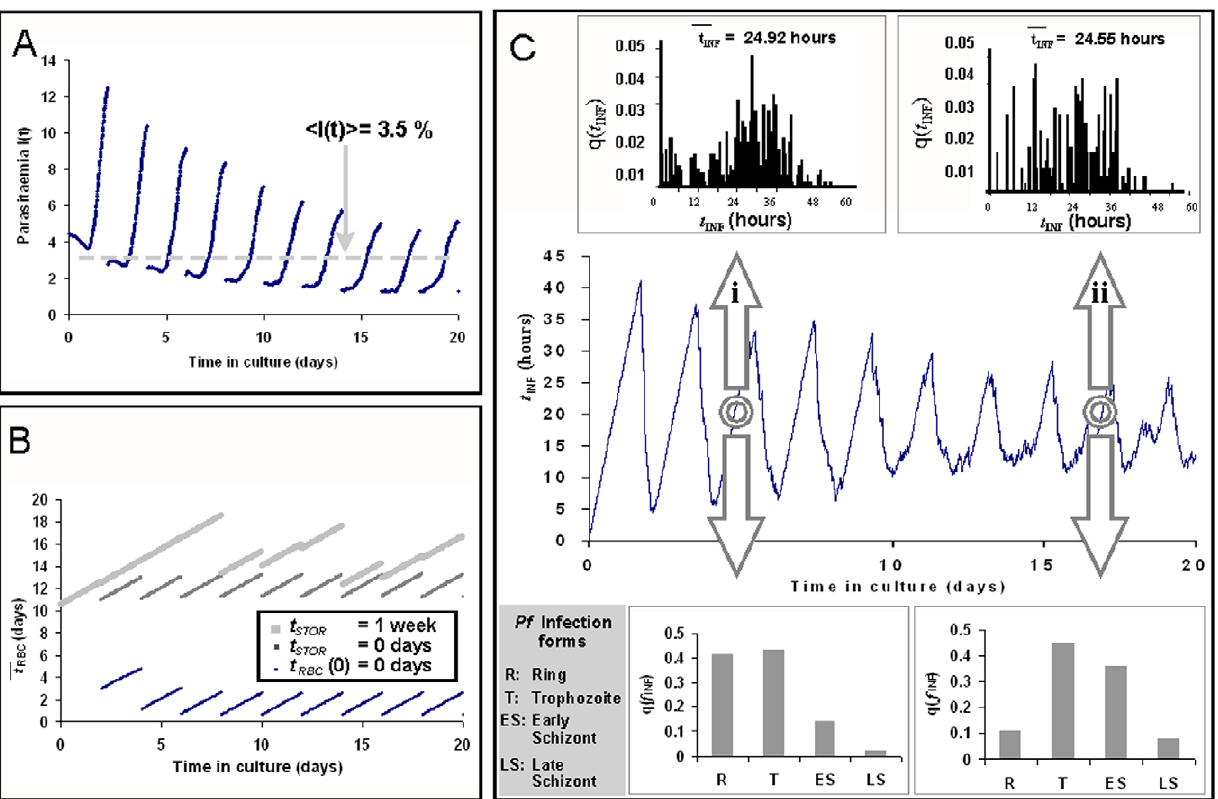
Figure 1. Outcome of simulated cultures. Evolution of a standard static culture with synchronous inoculum ( (cid:2) tt INF 0 ð Þ ~ 3 hours ), sub-cultivations every two days and one week storage of the blood source. A) Percentage of infected forms. B) Evolution of the mean age of RBCs in culture ( (cid:2) tt RBC ) through time in culture (days) for different storage periods of the blood source ( t STOR ). The label t RBC (0) ~ 0 indicates an inoculum comprised by RBCs with age 0. C) Mean post-invasion time of IRBCs in culture ( (cid:2) tt INF ). Samples of the culture with similar (cid:2) tt INF show different distributions ( q t INF ð Þ and q f INF ð Þ ) at day 4 (i) and at day 12 (ii), revealing that the population becomes increasingly desynchronised.